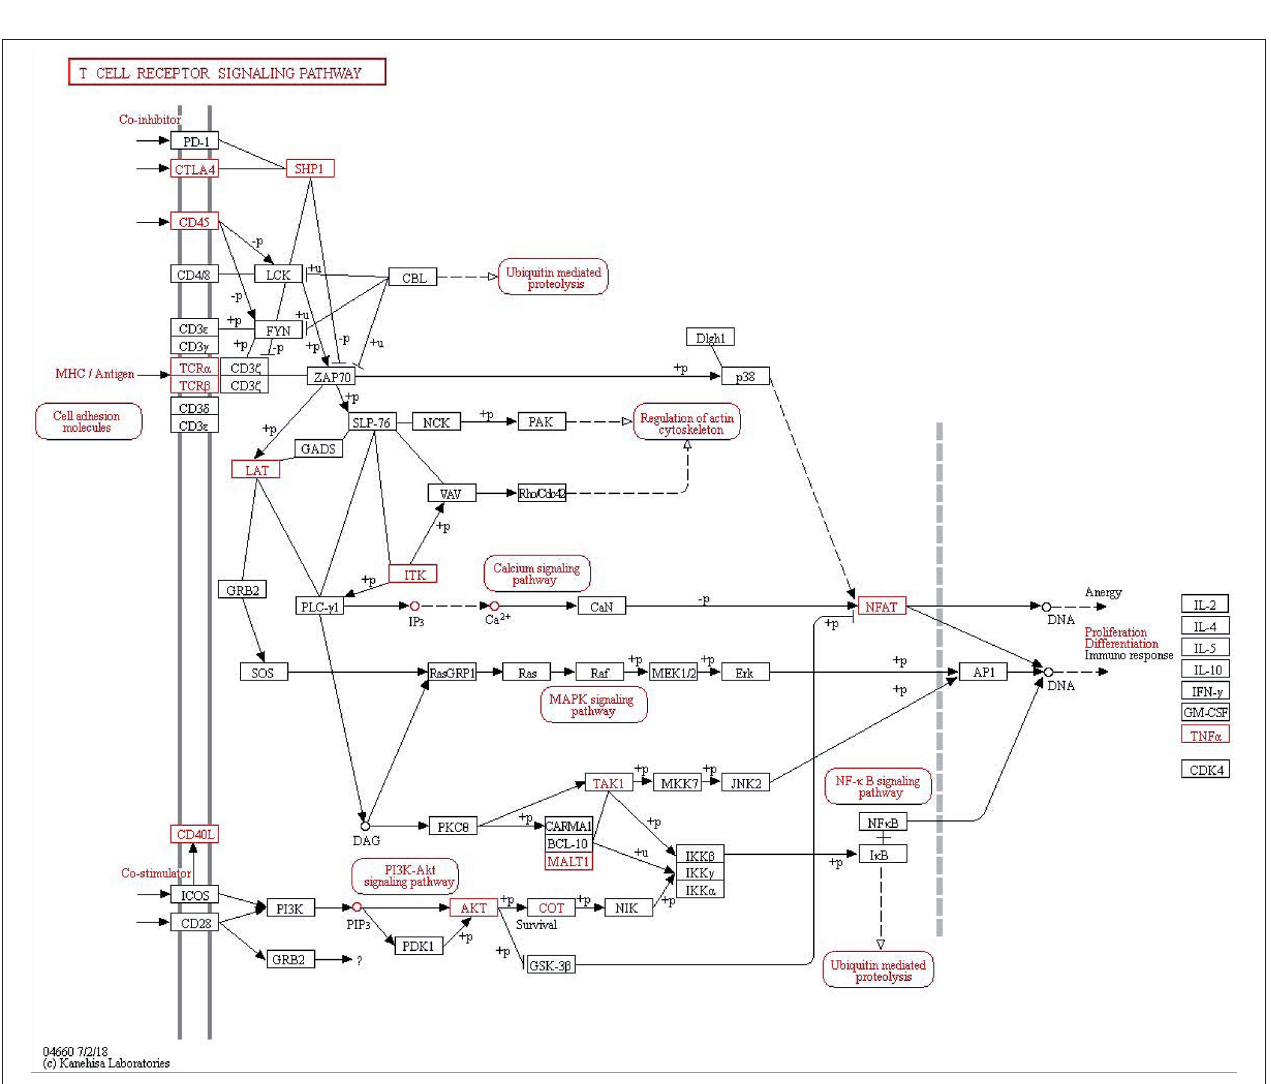
FIGURE 1 | expression between asthma and control groups. Red spots indicate a > 2.0-fold change in mRNA expression between asthma and control groups. Green spots indicate a < 0.5-fold change between asthma and control groups. (D) Heat map analysis of differentially expressed mRNAs between asthma and control group. Blue indicates low lncRNA expression and red indicates high lncRNA expression. (E) Venn diagram showing differential expression of mRNAs between asthma and control groups. (F) Venn diagram showing differential expression of lncRNA between asthma and control groups. (G) Gene Ontology (GO) analysis of differentially expressed lncRNAs between asthma and control groups. The most enriched GO terms targeted by dysregulated transcripts were involved in a variety of functions, such as immune response, immune system process, cellular response to stress, and response to stress. (H) Gene Ontology (GO) analysis of differentially expressed lncRNAs between Eos and Neu groups. The enriched GO term targeted by dysregulated transcripts was involved in multiple metabolic processes.